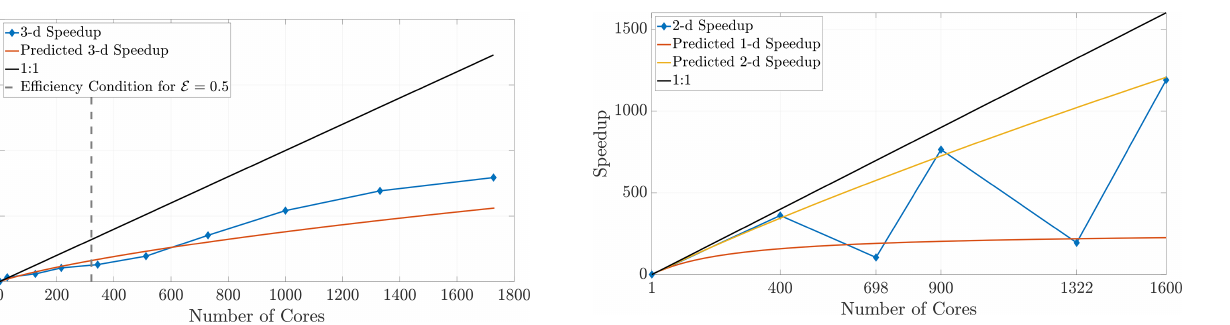
Figure 13. Observed (diamonds) and theoretical speedup for 3-D simulations. Each chosen number of cores is a perfect cube so that the checkerboard method gives cubic subdomains. With the chosen parameters L = 100, D = 1, and (cid:49)t = 0 . 1 and a desired efficiency of 0.5, the upper bound given by the inequality (29) is not violated for the checkerboard method until around 320 cores.